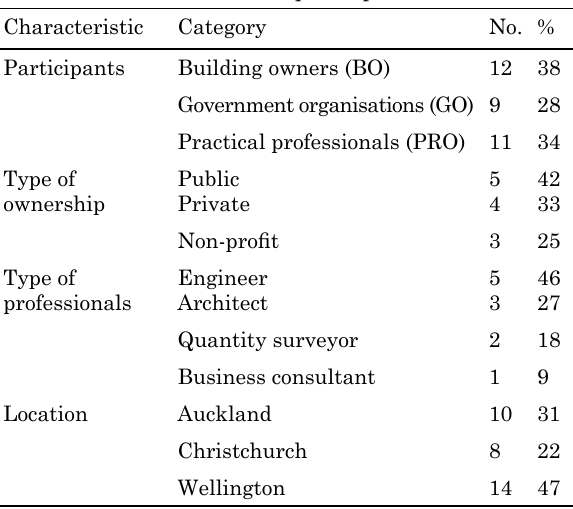
Table 2. Profile of interview participants